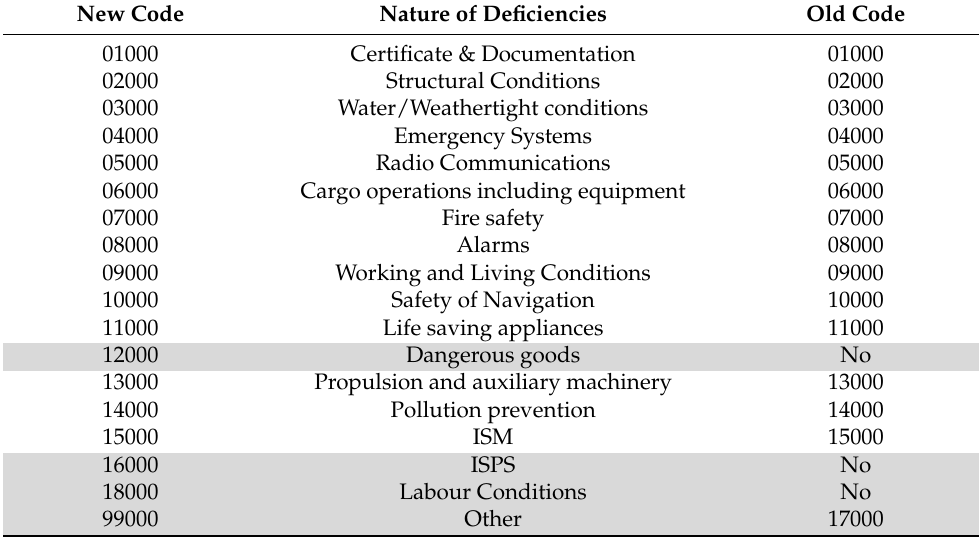
Table 1. Comparison table of the new and old PSC code deficiencies by